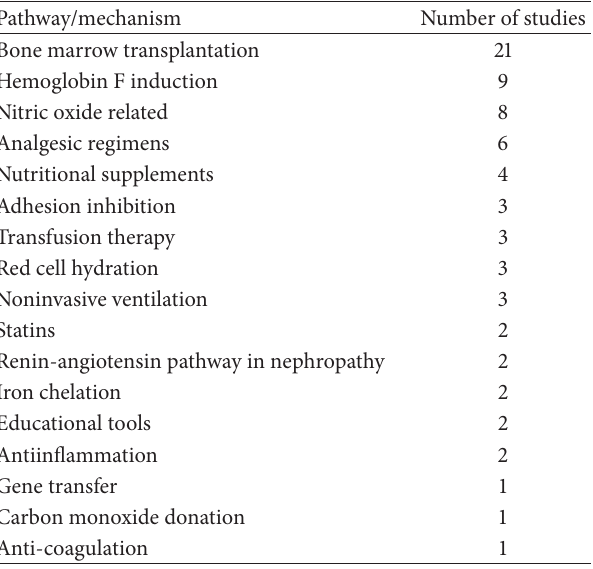
Table 1: Major types of sickle cell intervention studies registered on the website http://www.clinicaltrials.gov/, as of December 1, 2012, of a total of 96